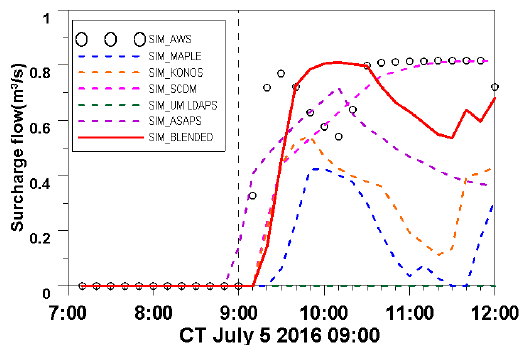
Figure 13. Actual flooding locations in the Bakwoon basin.